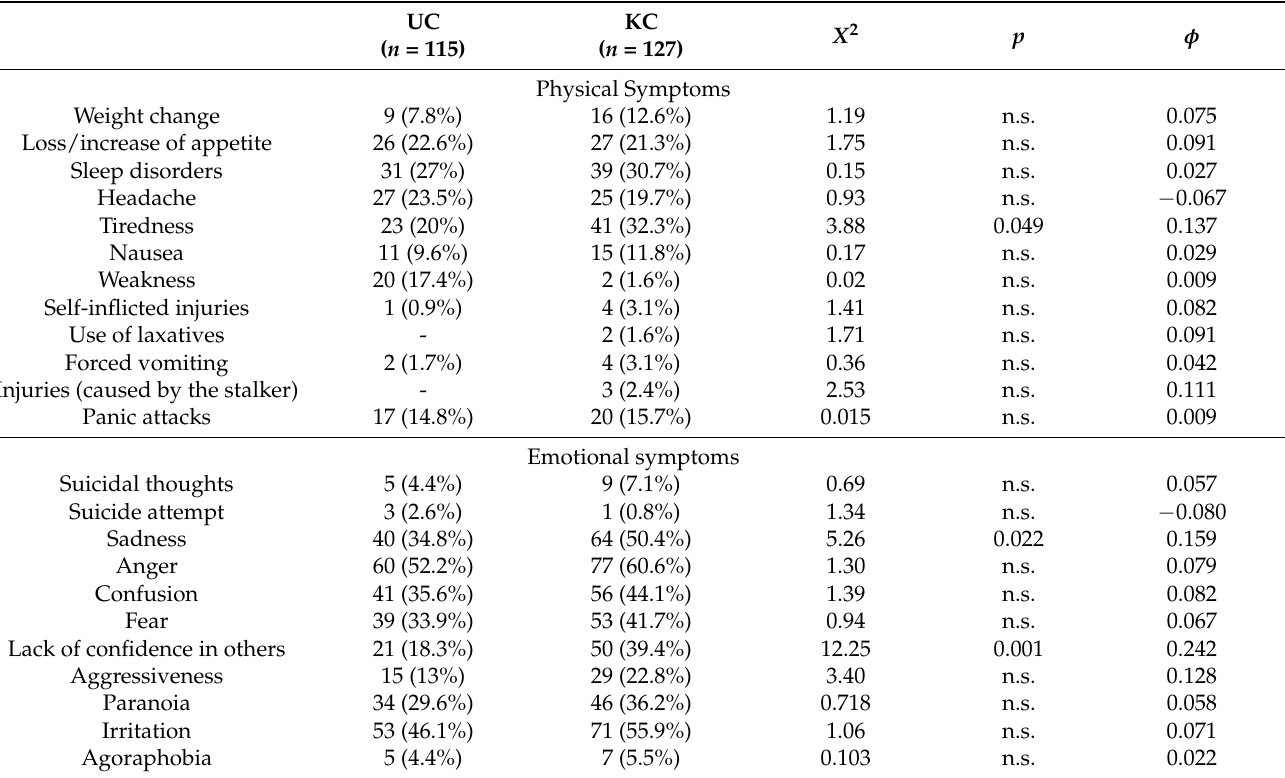
Table 2. Physical and emotional symptoms: comparison between victims of UC and KC (percentage in